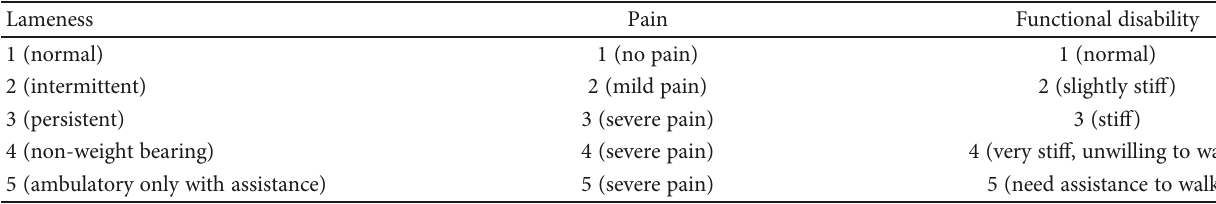
Table 3: Symptoms of arthritic knee; lameness and pain scores # .